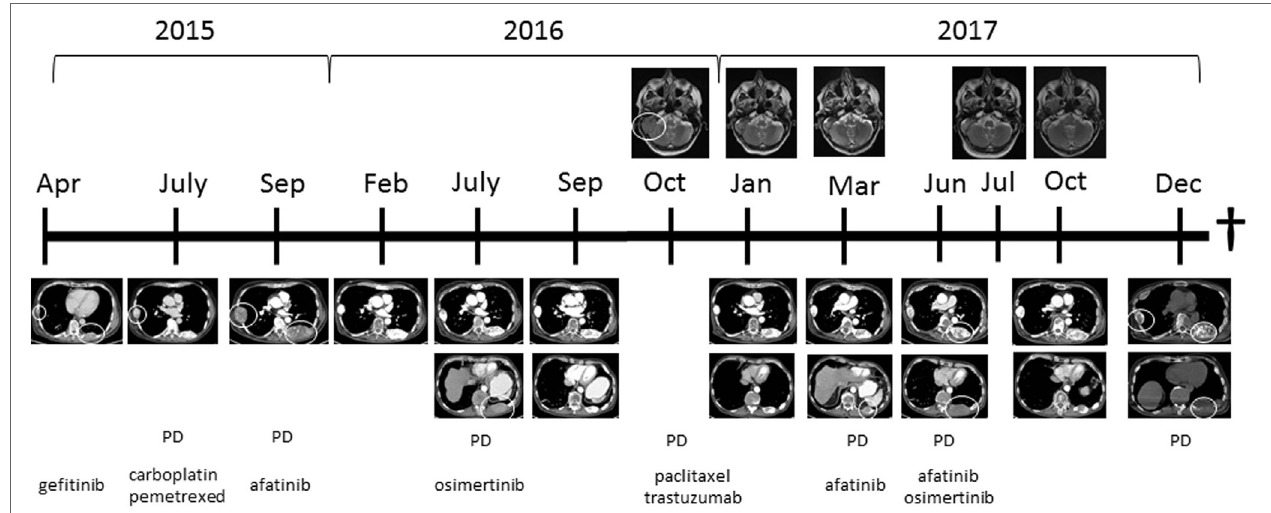
FIGURe 1 | Computed tomography images showing the thoracic wall lesions of the adenocarcinoma of the lung and MRI images showing the metastasis in the skull with ingrowth in the brain at different time points in combination with treatment started at those time points. Abbreviation: PD, progressive disease. White circles indicate lesion, which showed